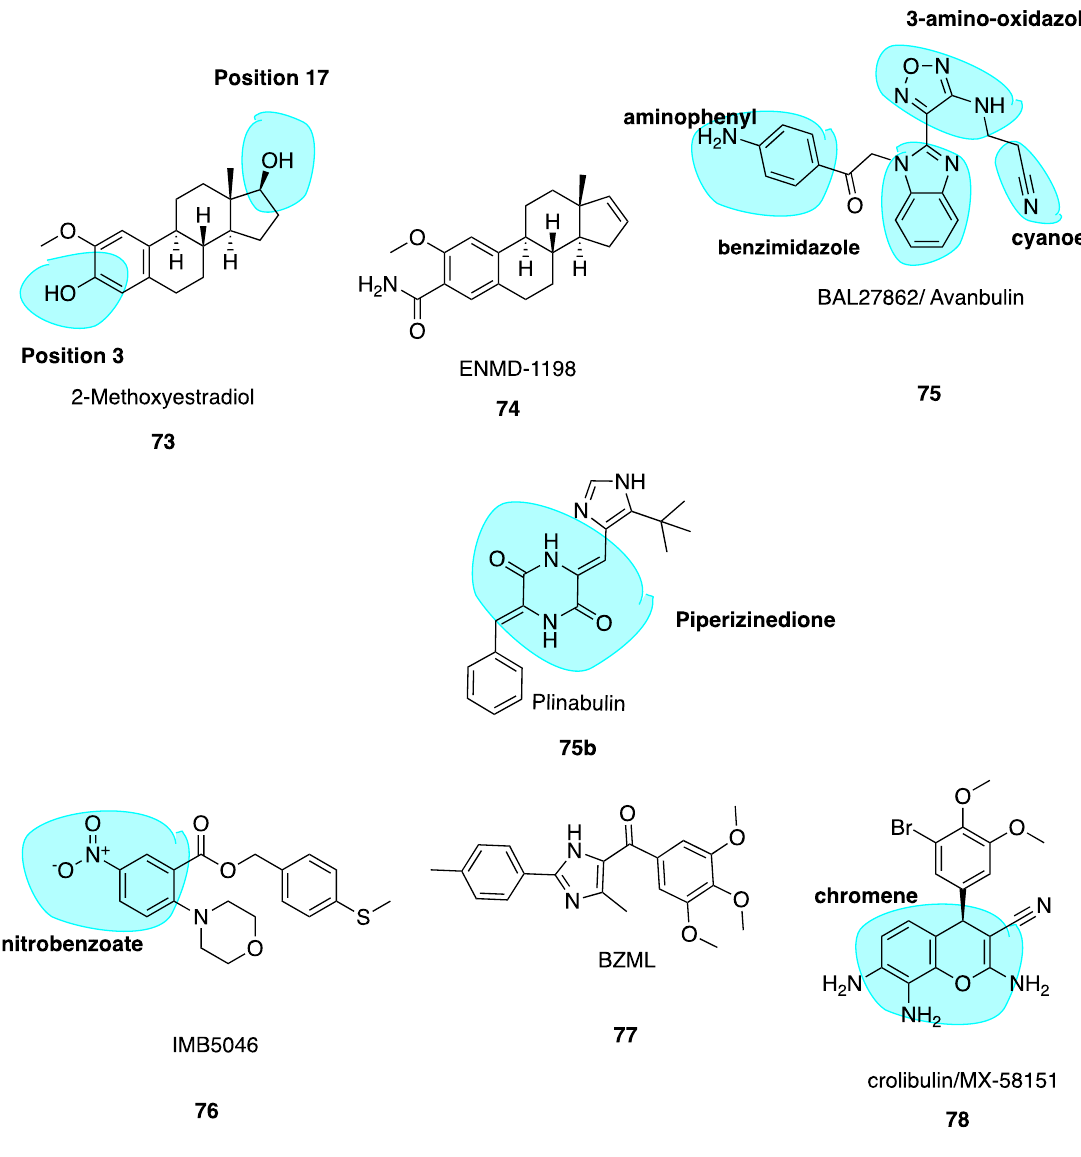
Figure 11. Structures of compounds 73 – 78 .